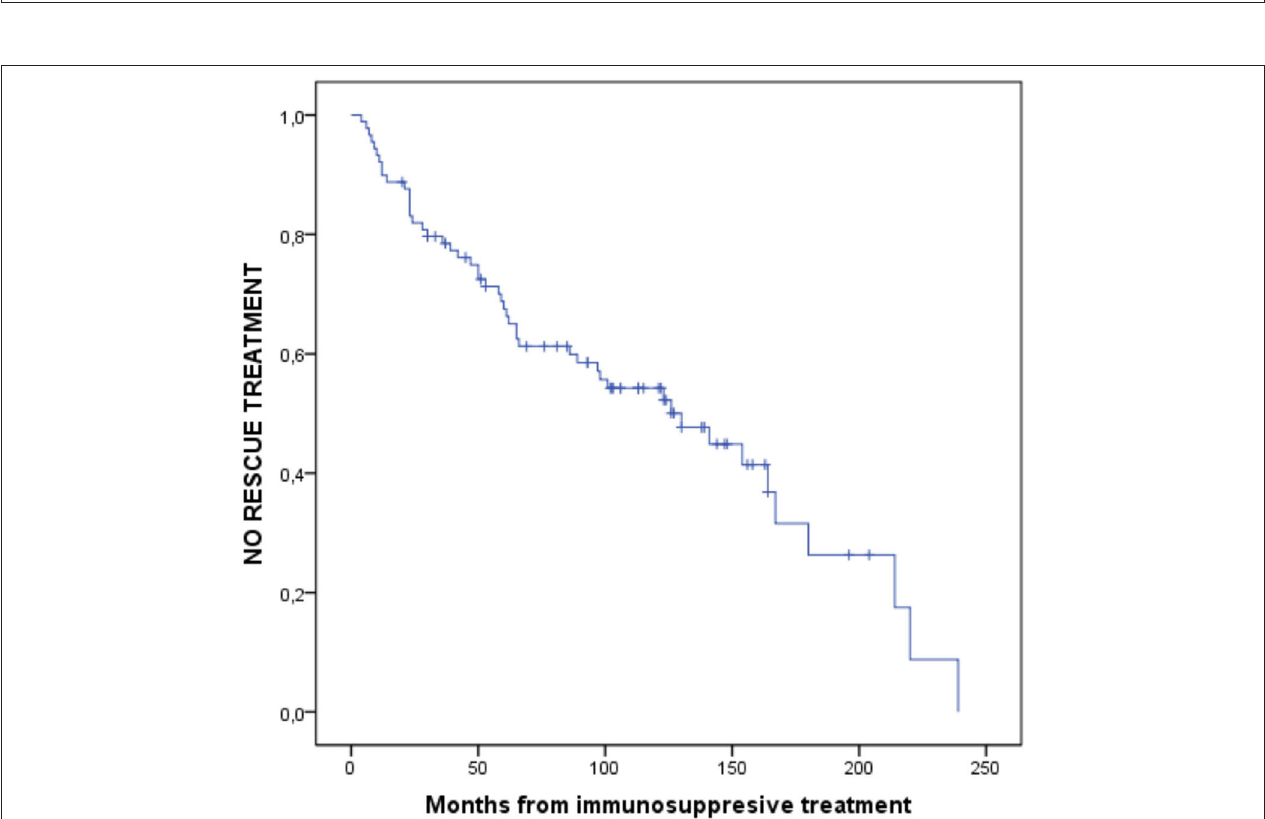
FIGURE 4 | Probability of NO rescue therapy from IMM treatment to the end of follow-up.